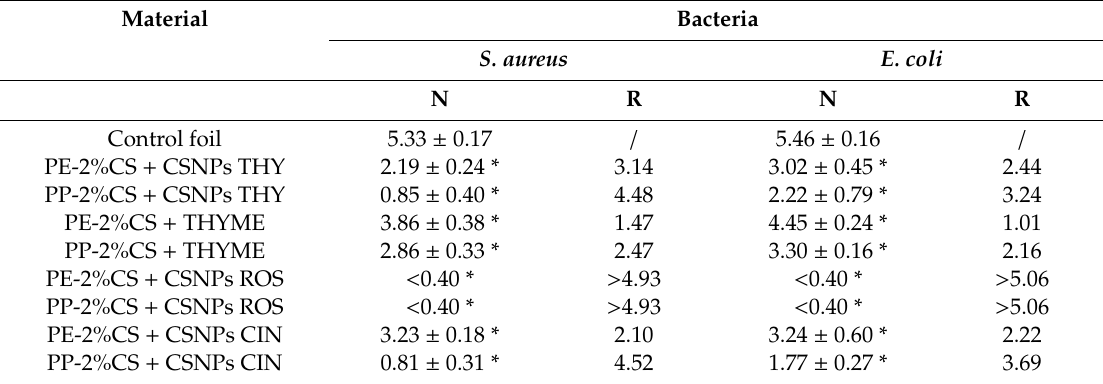
Table 9. Antimicrobial activity against Gram-positive ( Staphylococcus aureus ) and Gram-negative bacteria ( Escherichia coli ).